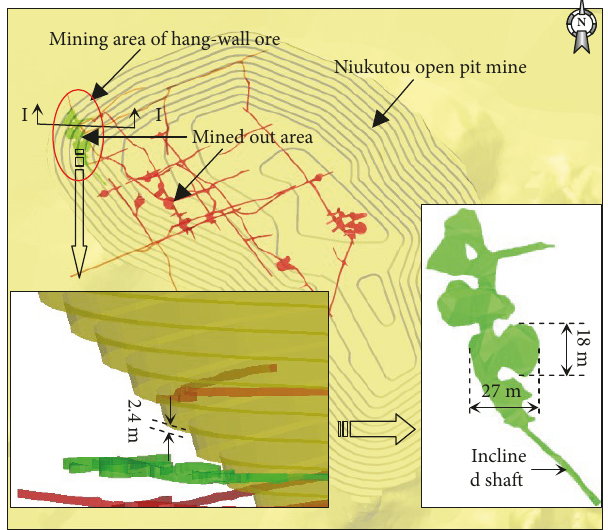
Figure 1: Distribution and scale of mined-out areas under Niukutou open-pit